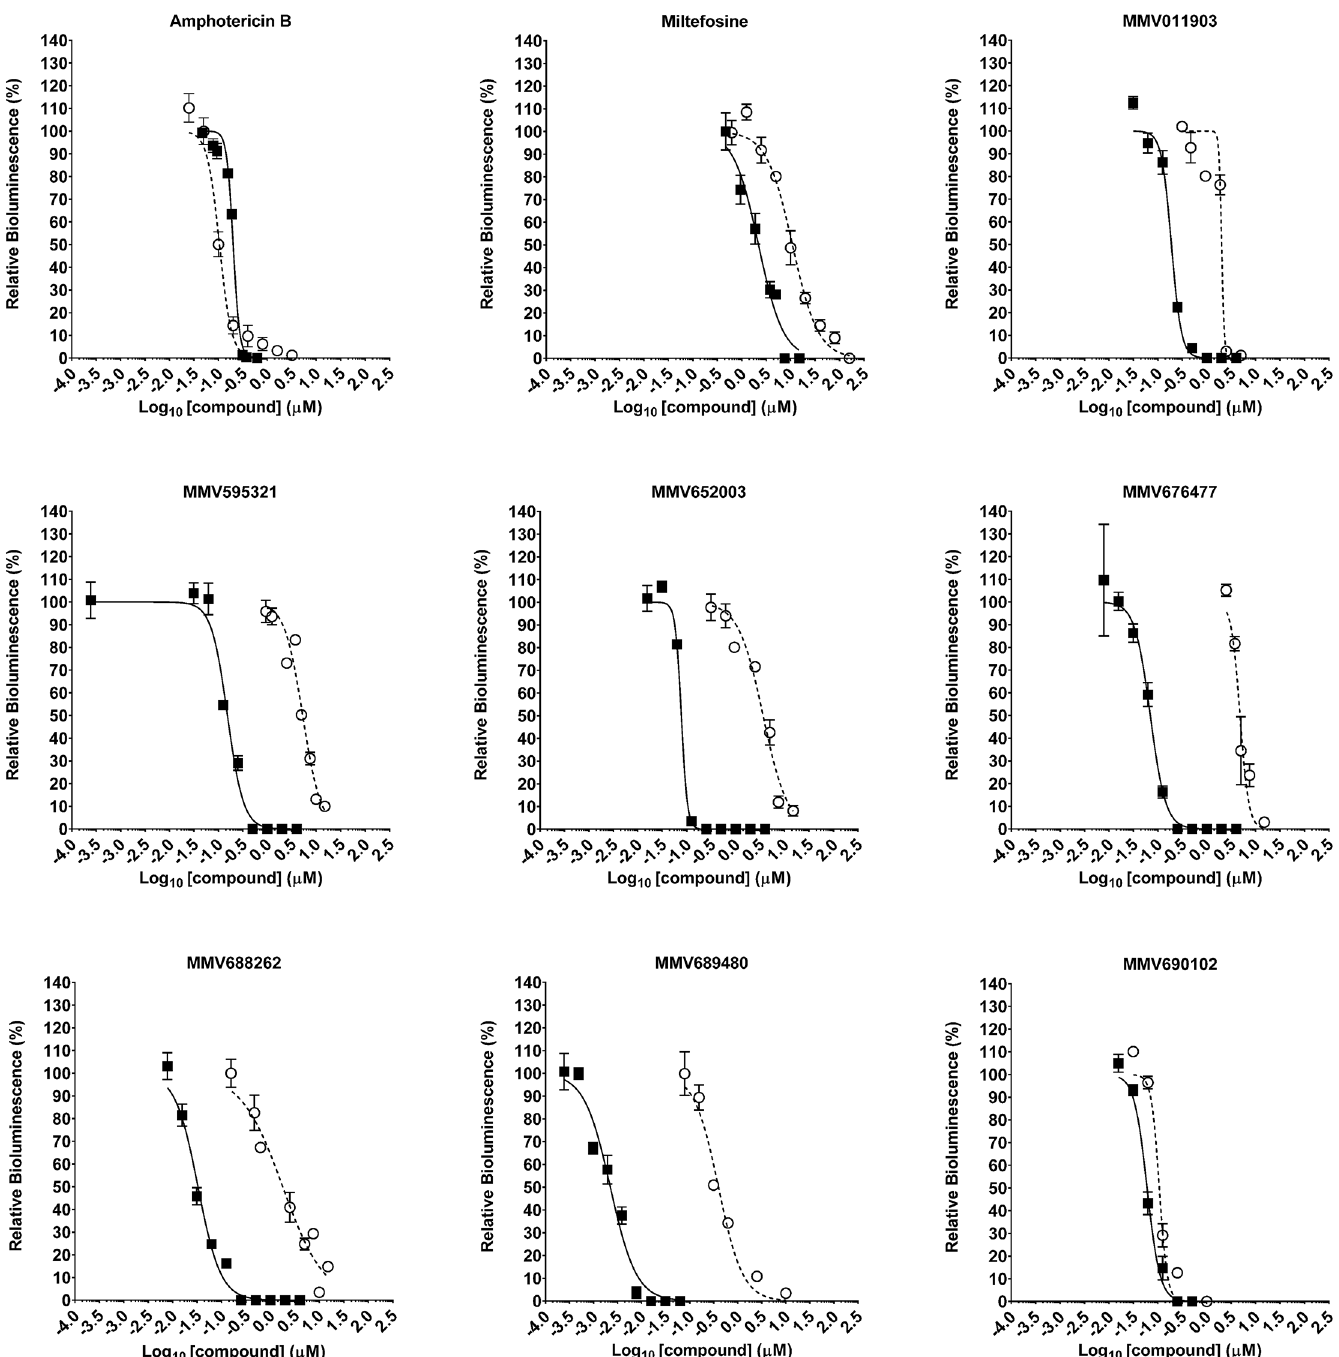
Fig 4. EC 50 responses to seven MMV Pathogen Box compounds in both axenic and intramacrophage assays, compared to Amphotericin B and Miltefosine. The response of L . mexicana expressing NanoLuc-PEST when screened against seven hit compounds, and the two controls Amphotericin B and Miltefosine. Parasites were screened as either axenic amastigotes (filled square) or as intramacrophage amastigotes (open circle) in the THP-1 infection model. Mean values are shown (n = 4) ± SD from two independent experiments. EC 50 and EC 90 values are detailed in Table